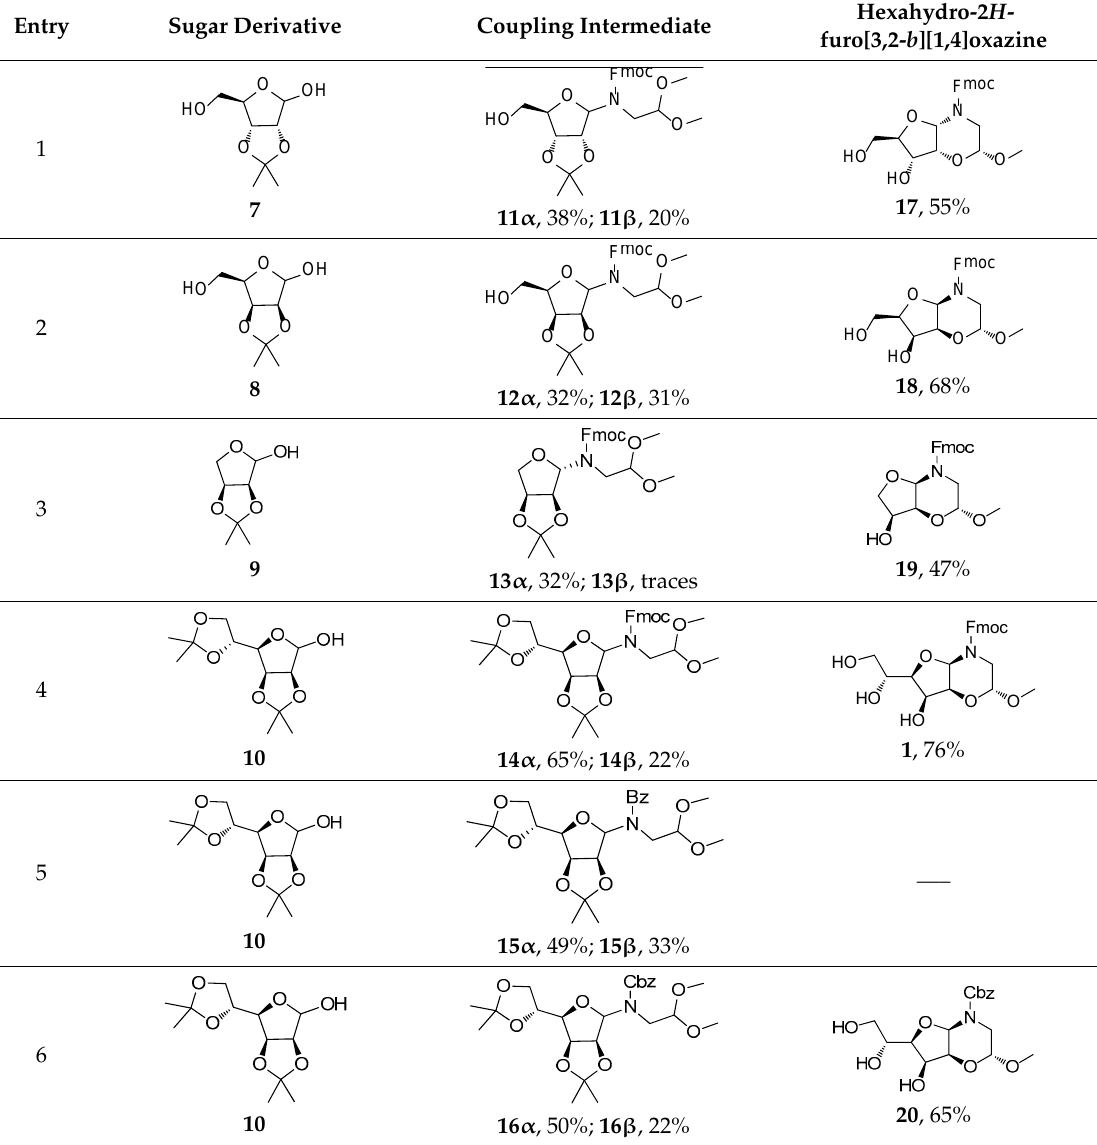
Table 1. Structures and yields of hexahydro-2 H -furo[3,2- b ][1,4]oxazine compounds.